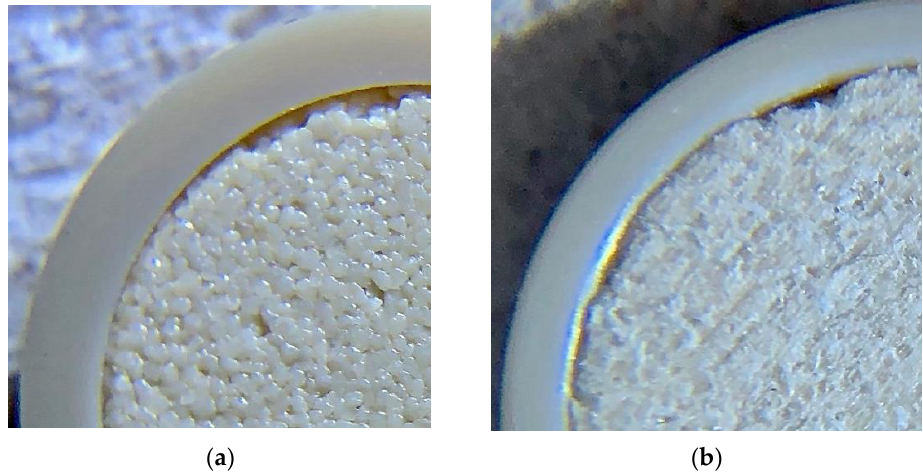
Figure 9. Comparison of ( a ) a new PEEK frit, showing nominal 5 µ m pores, with ( b ) frit recovered from the inlet end of Col-3 after reaction with MGW, showing reduced porosity and precipitate blocking the